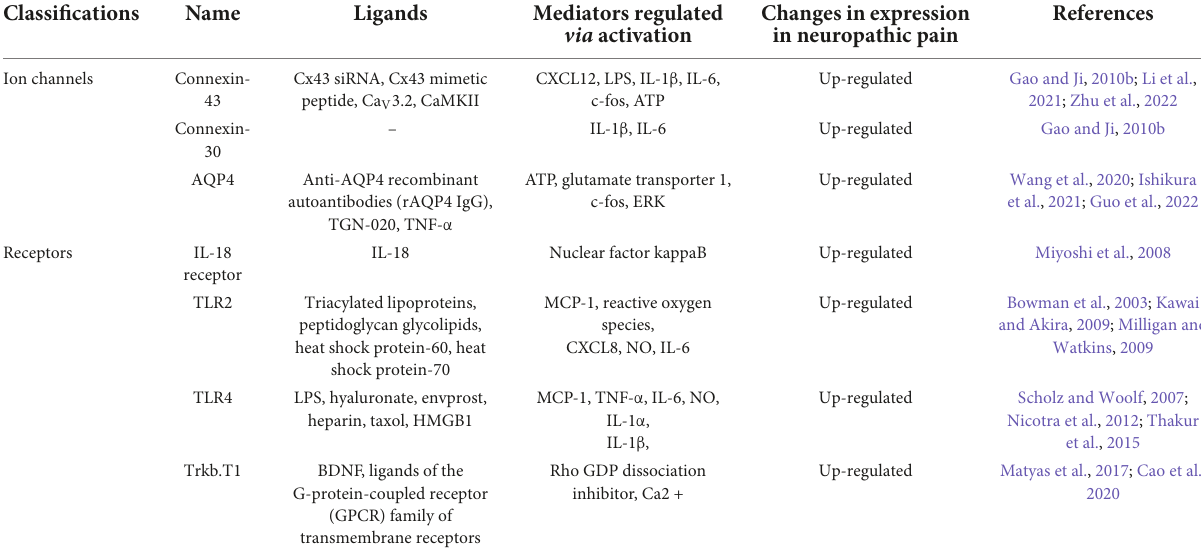
TABLE 1 Expression of ion channels and receptors in astrocytes.